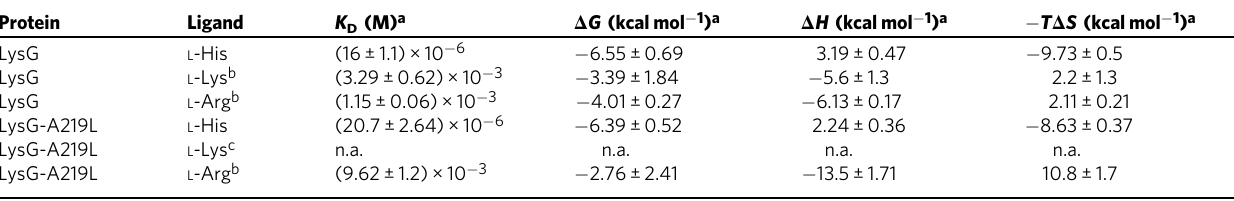
Table 1 Thermodynamic binding parameters of LysG and LysG-A219L.